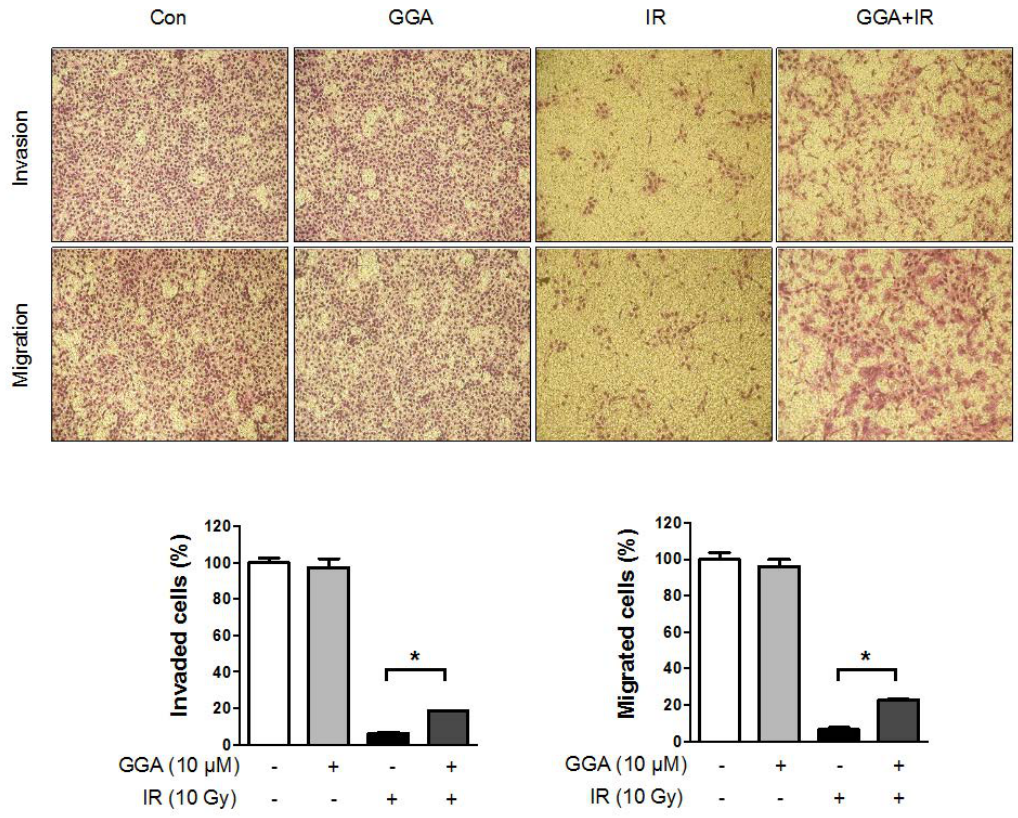
Figure 4. Effects of GGA on endothelial cell mobility. Endothelial cell invasion and migration was evaluated 12 h after treatment with 10 µM GGA and/or radiation. Representative images of the migrated cells on the lower surface of the filter (40×) and quantification ( n = 3, * p < 0.05).